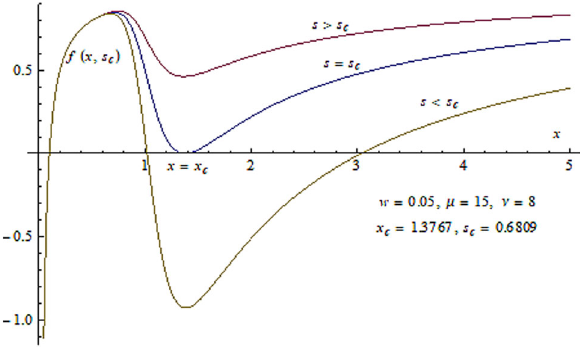
Fig. 5 Behavior of f ( x ; s ) for fixed values of parameter s < s c and w = 0 . 05, μ = 15 ,ν = 8